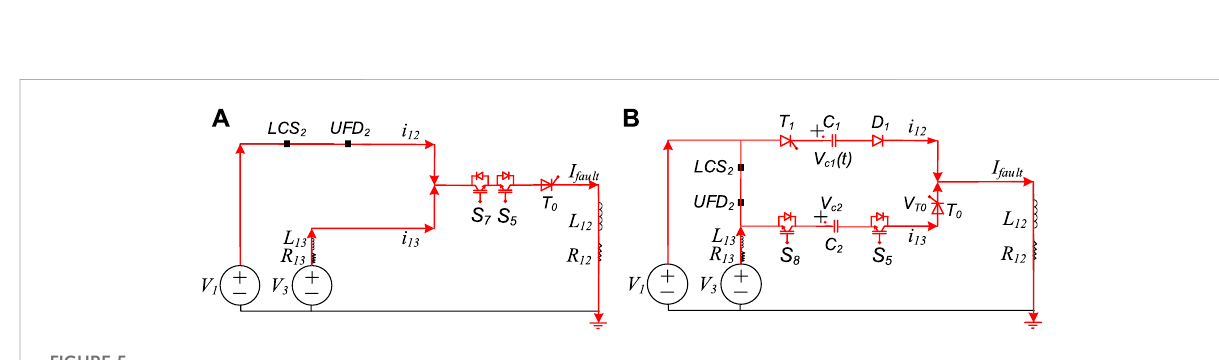
FIGURE 5 Impli fi ed equivalent circuit of current commutation process. (A) t 3 - t 4 (B) t 4 - t 5